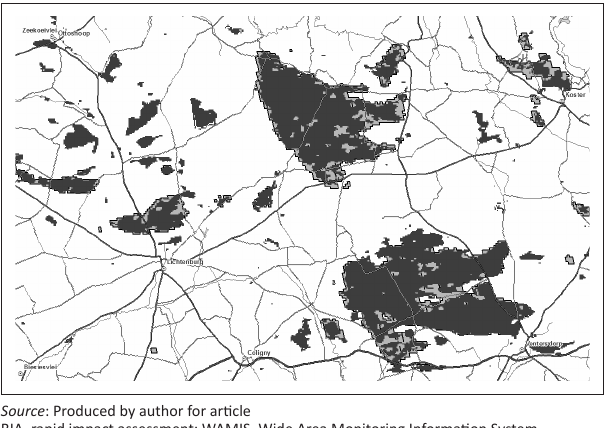
FIGURE 8: Verification of the RIA–MODIS data, comparing it with the WAMIS burned area data.